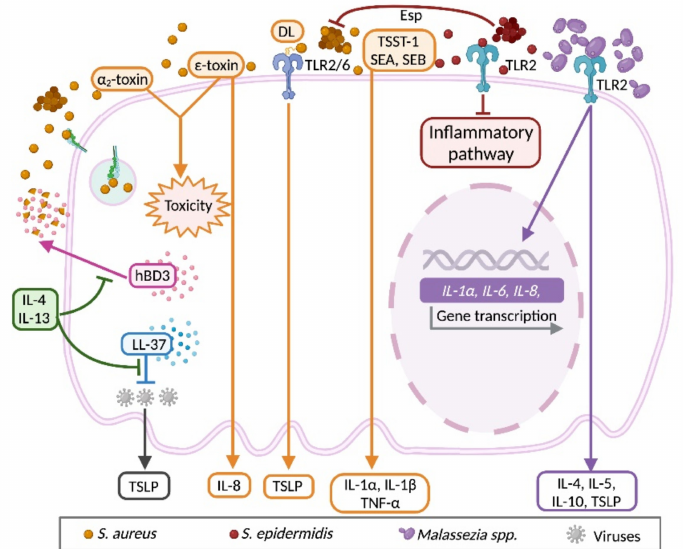
Figure 5. Keratinocyte response to microbiota stimuli under the type 2 immune milieu. KCs recognize bacteria, fungi, and viruses from skin microbiota through specific receptors. Colonization with Staphylococcus aureus is present in the skin of AD patients, and the bacteria or their components can activate KCs to secrete proallergic (TSLP) and proinflammatory (IL-1 α , IL-1 β , IL-8, TNF- α ) cytokines, exacerbating the underlying immune response. Exotoxins from S. aureus can also damage the cell. Chronic infection of S. aureus is partly due to its internalization into KCs through extracellular adherence protein recognition. Th2 cytokines (IL-4, IL-13) avoid S. aureus destruction by KC-derived hBD3. As Staphylococcus epidermidis / S. aureus ratio is diminished in AD skin, the anti-inflammatory and protective effects, and the anti-microbial properties of S. epidermidis on KCs and S. aureus , respectively, are impaired. In response to Malassezia colonization, KCs express proinflammatory IL-1 α , IL-6, and IL-8, and release type 2 (IL-4, IL-5, IL-10, TSLP) cytokines. Levels of LL-37 in KCs are down-regulated by type 2 cytokines, increasing viral replication and dissemination of vaccinia, herpes simplex and human papilloma viruses, which at the same time promotes type 2 inflammation through an induction of TSLP expression by the cell. Abbreviations: DL, diacylated lipopeptide; Esp, serine protease; hBD3, human β -defensin 3; LL-37, cathelicidin LL-37; SEA, staphylococcal enterotoxin A; SEB, staphylococcal enterotoxin B; TNF, tumoral necrosis factor; TSST-1, toxic shock syndrome toxin. Created with BioRender.com (access date: 30 August